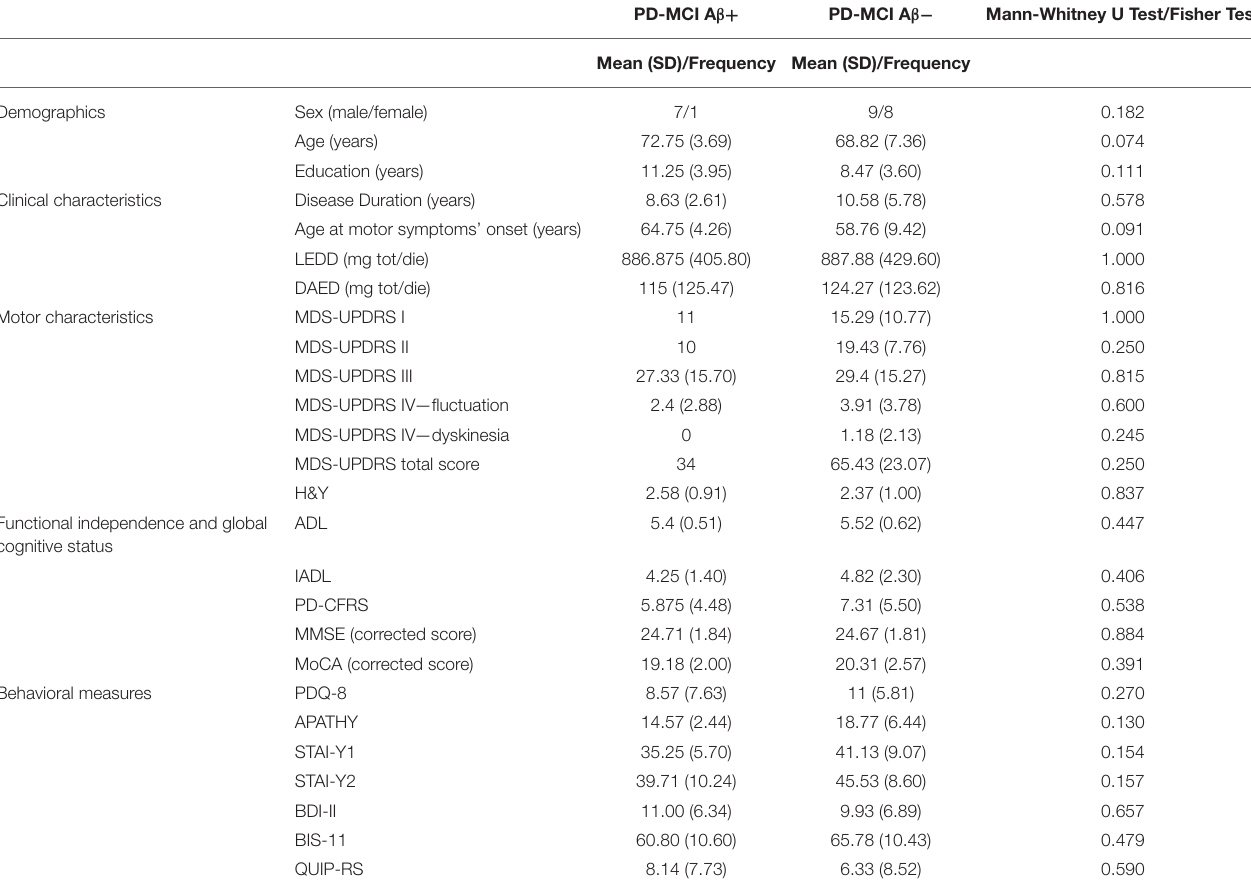
TABLE 1 | Demographical, clinical, motor, and behavioral characteristics of PD-MCI A β + vs. A β